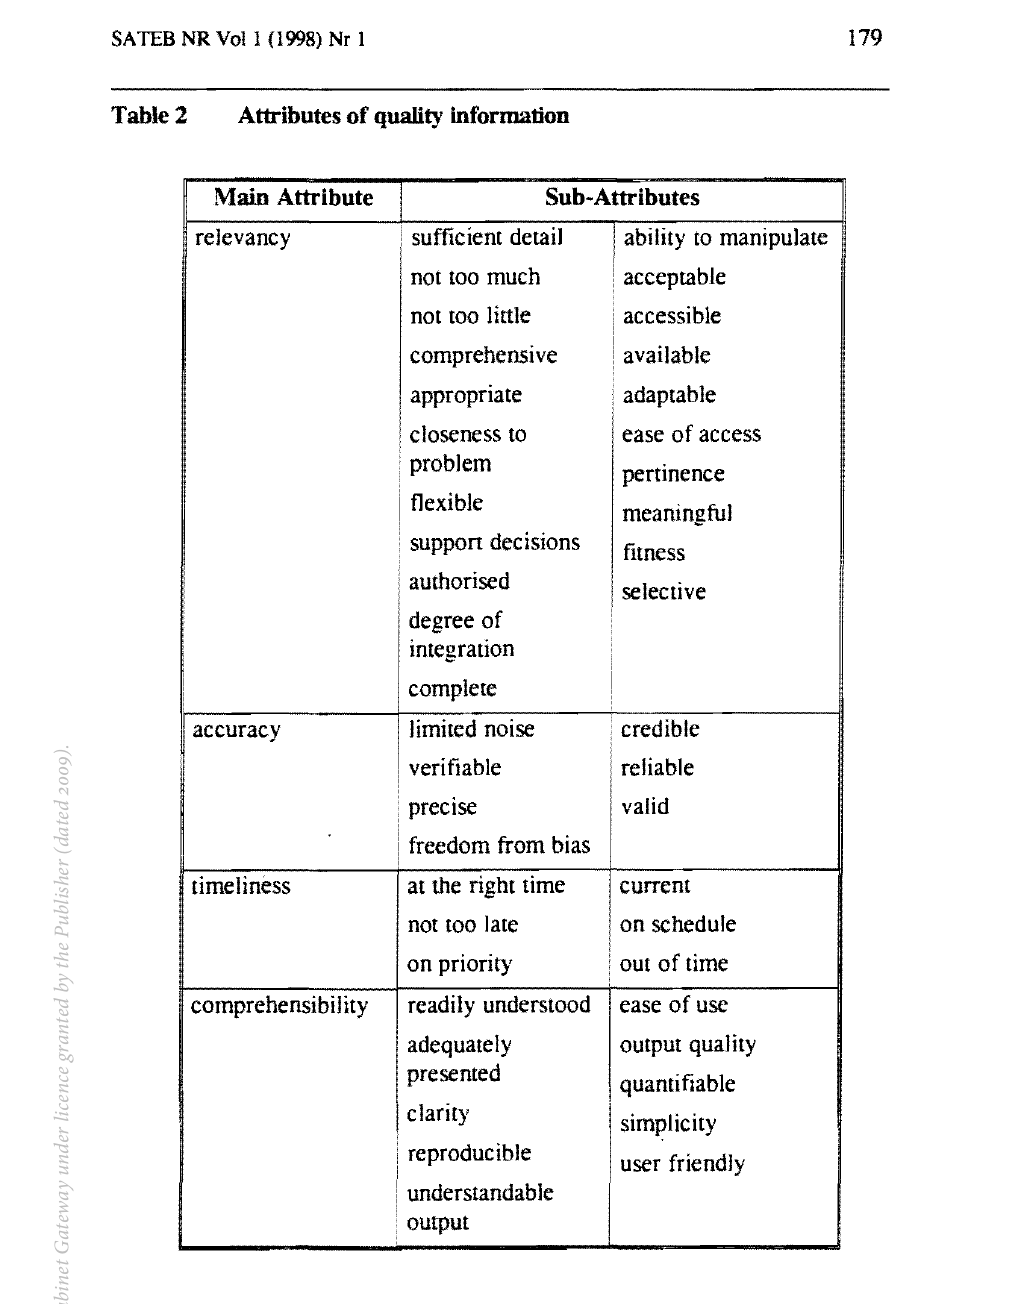
Table 2 Attributes of quality information Main